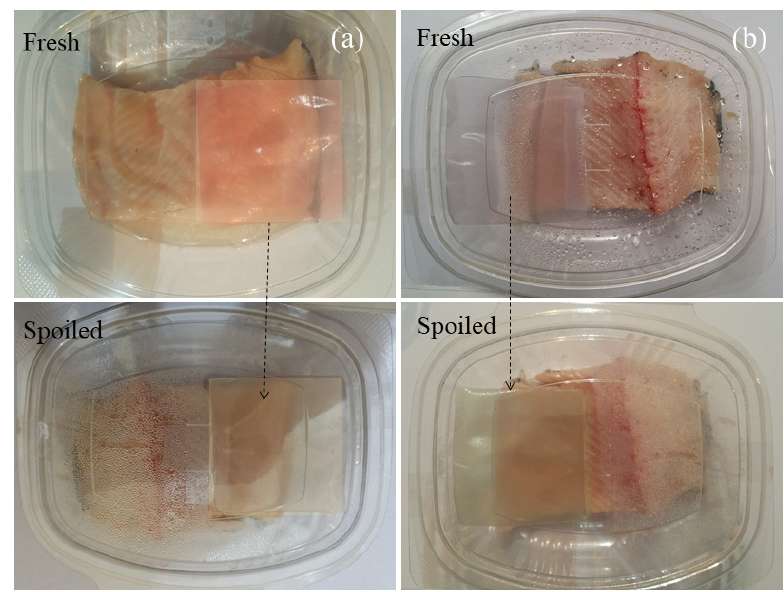
Figure 6. Application of smart colorimetric indicators to monitor the freshness of fish. ( a ) G/CsNFs/BAs; ( b ) G/CsNFs/SPAs. BAs; ( b )